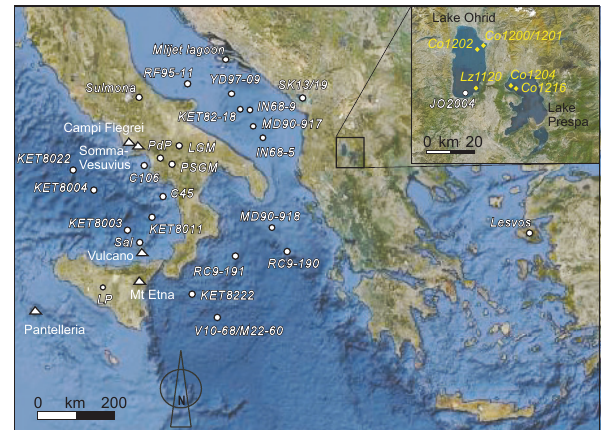
Fig. 1. Location map of the study area. A close view of lakes Ohrid and Prespa is shown in the framework in the upper right an- gle, along with the locations of the studied cores. Triangles indi- cate Italian volcanoes of interest for this study. White dots indicate the cores used for tephra correlations: LP, Lago di Pergusa (Sadori and Narcisi, 2001); JO2004, Albanian side of Lake Ohrid (Caron et al., 2010a; L´ezine et al., 2010); LGM, Lago Grande di Montic- chio (Wulf et al., 2004), Sulmona (Giaccio et al., 2009), YD97-09, RF95-11 (Lowe et al., 2007); IN68-5, IN68-9 (Calanchi and Dinelli, 2008); KET82-18, KET80-03, KET80-04, KET80-011, KET80-22 (Paterne et al., 1988); KET82-22 (Paterne et al., 2008); MD90-917 (Siani et al., 2004); MD90-918 (Caron et al., 2010b; Zanchetta et al., 2010); C45, C146 (Buccheri et al., 2002); V10-68, M22-60, RC9-190, RC9-191 (Keller et al., 1978); PSGM, Pantano San Gre- gorio Magno (Munno and Petrosino, 2006); Mlijet lagoon (Jahns and van den Boogard, 1998); SK13/19, Shkodra lake (Sulpizio et al., 2010); Lesvos (Margari et al., 2007); PdP, Pian di Pecore (Zanchetta et al., 2010); Sal, Salina island (Lucchi et al.,